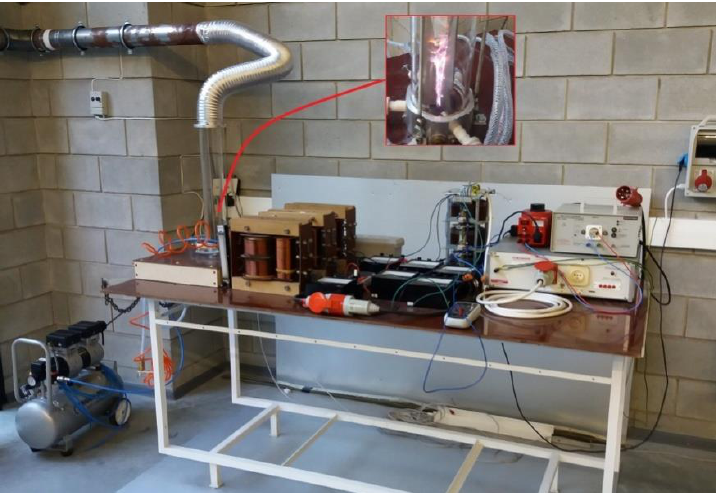
Figure 2. Laboratory installation of a 3-phase GlidArc plasma reactor.